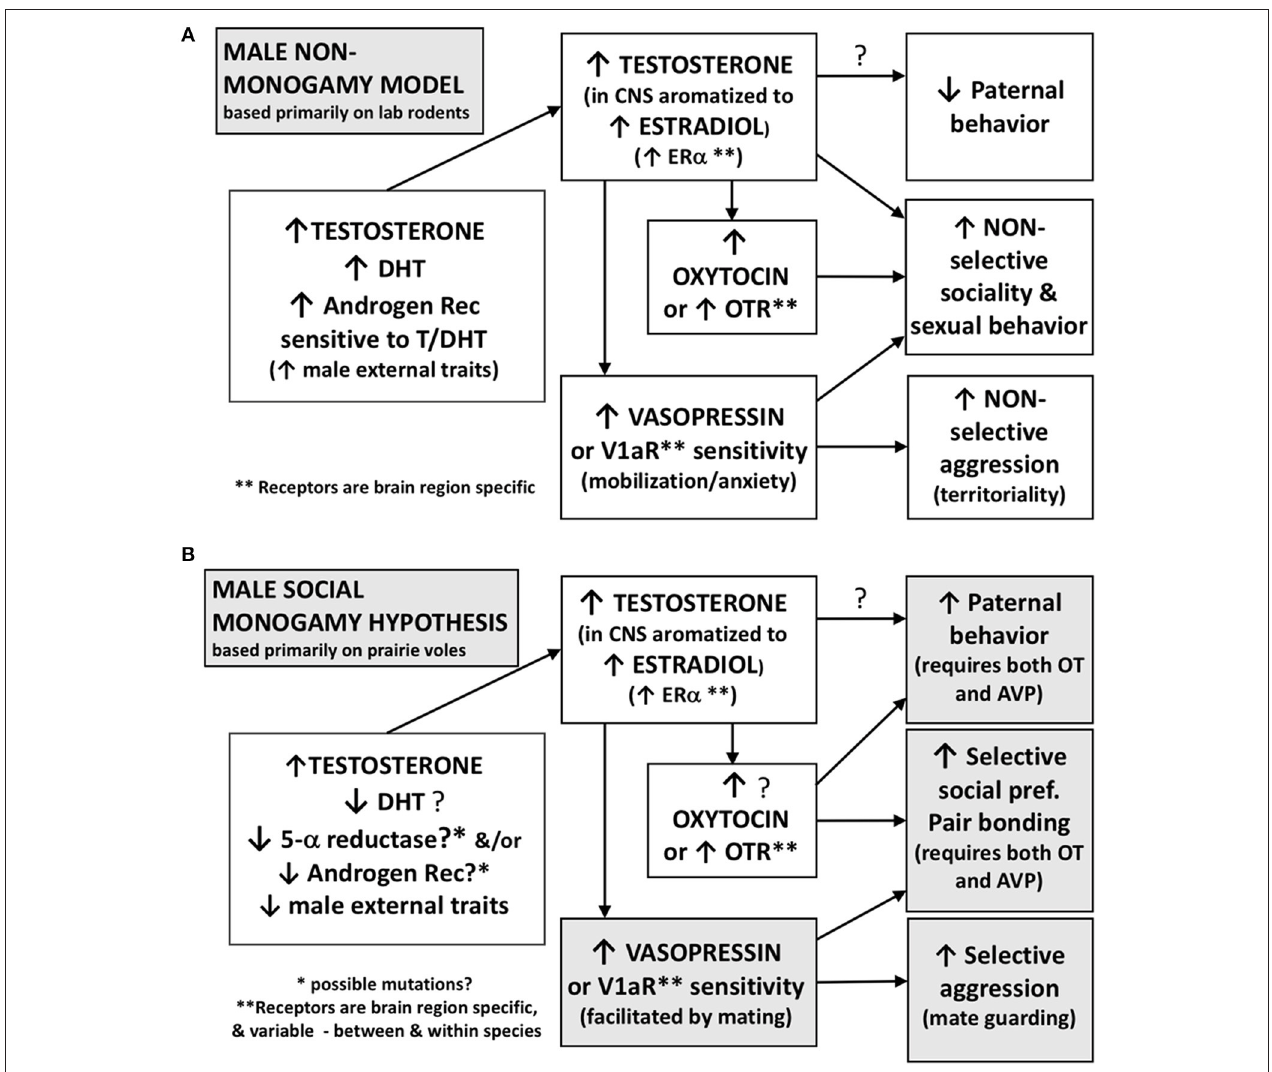
FIGURE 2 | Functional differences in the effects of steroids and peptides may contribute to non-monogamous vs. socially monogamous behavioral phenotypes in males. This hypothesis is based primarily on data from laboratory rodents including prairie voles. (A) Males of non-monogamous species often display a suite of behaviors that include low levels of paternal investment, non-selective social and sexual behavior, and non-selective aggression that typically occurs when competing for a mate or territory. These behaviors are facilitated by high levels of androgens and a high sensitivity of the androgen receptor. High levels of testosterone, some of which is aromatized locally to an estrogen, may contribute to low levels of paternal behavior and lead to non-selective social behavior and mating. In addition, vasopressin, facilitated by androgens, is involved in mating- and territory-related aggression in these males. (B) In socially monogamous males, we hypothesize that decreased sensitivity of the androgen receptor, or possibly lower levels of DHT, with a concurrent increase in vasopressin, could contribute to high levels of paternal investment, selective social preferences, and selective mate guarding aggression. Testosterone can be aromatized locally to estrogen and also facilitate the release of oxytocin and